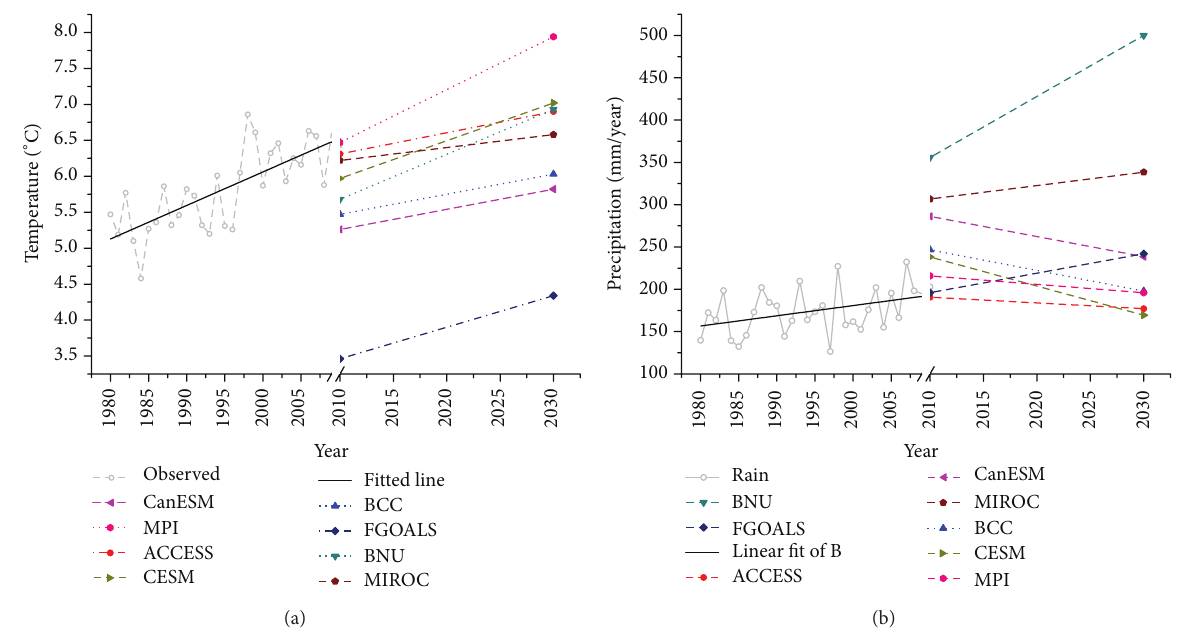
Figure 2: The trends in (a) observed (grey line; running average in black) and projected (10AR5 GCMs; colored dash lines) temperature, (b) observed and projected